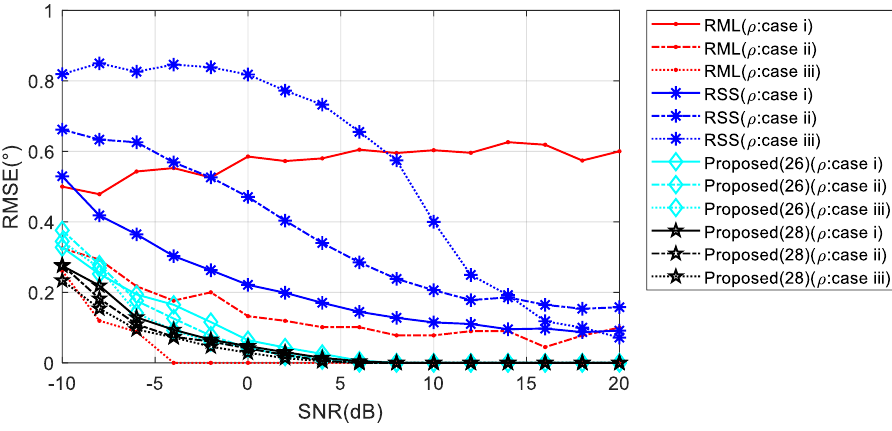
Figure 11. RMSE against input SNR with floating reflection coefficient when 𝜃 = 1°